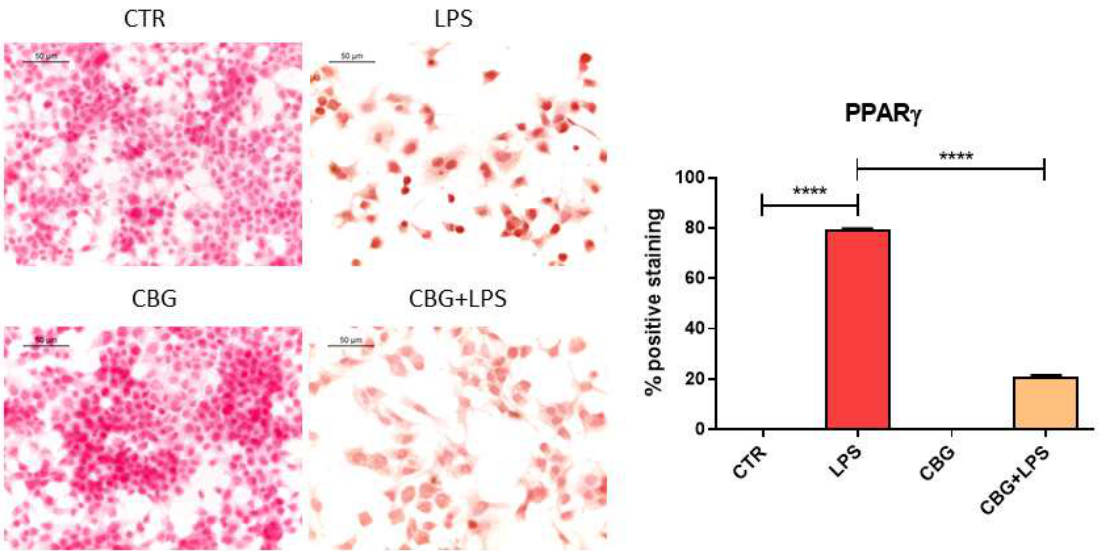
Figure 4. CBG pre-treatment was able to reduce the levels of PPARγ in NSC-34 cells treated with the medium of LPS-stimulated RAW 264.7 macrophages. The treatment with the medium of LPS-stimulated RAW 264.7 macrophages induced the expression of PPARγ, but CBG pre-treatment reduced its levels. The immunocytochemical assays were repeated three times. **** p <0.0001, NSC-34 cells treated with the medium of LPS stimulated macrophages vs. NSC-34 cells pre-treated with CBG and then exposed to the medium of LPS stimulated macrophages, NSC-34 cells treated with the medium of LPS stimulated macrophages vs. control; Scale bar: 50 µm.